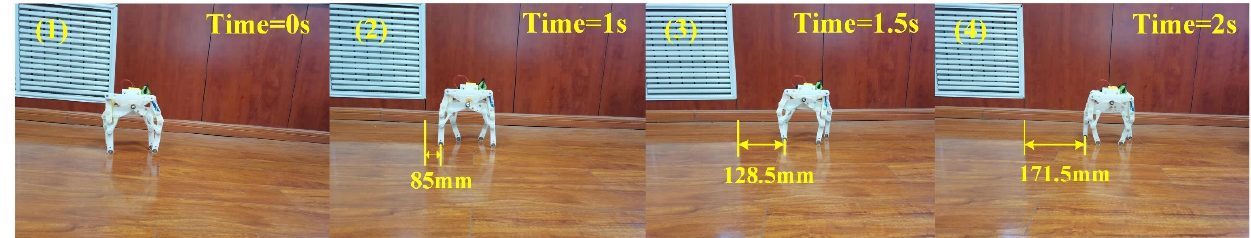
Figure 17. Plane walking test.